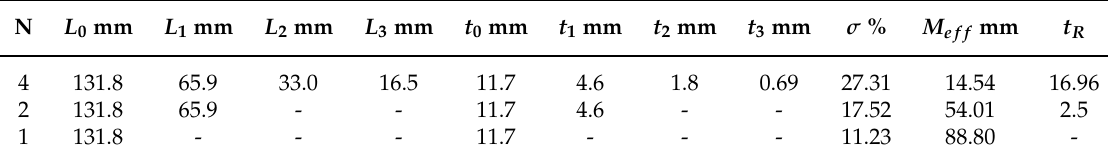
Table 1. Summary of the scaling parameters of fractal square grids (FG1, FG2 and FG4).